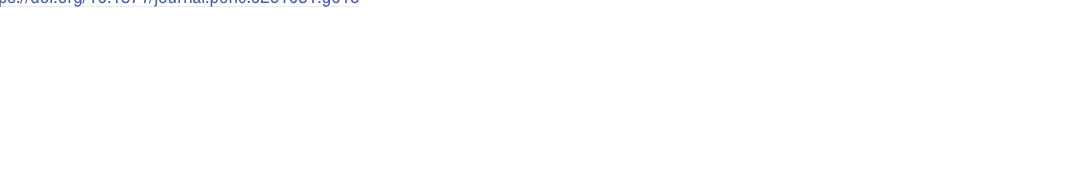
PLOS ONE | https://doi.org/10.1371/journal.pone.0261031 December23,